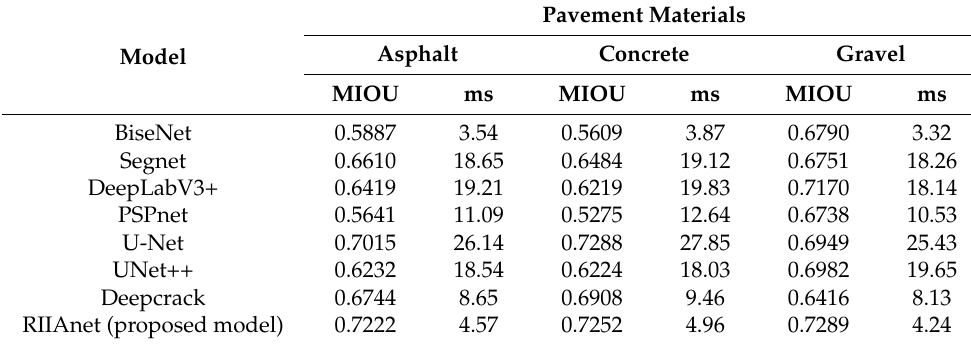
Table 5. Performance under different pavement materials.